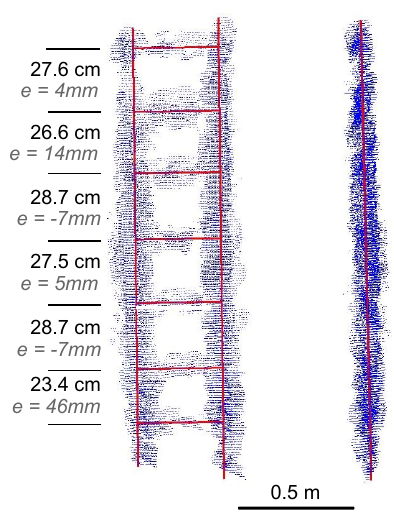
Figure 7: Ladder fitting. Left: front view with inter-rung dis- tances and errors (e) with respect to ground truth. Right: sectional view showing the adjustment of the ladder